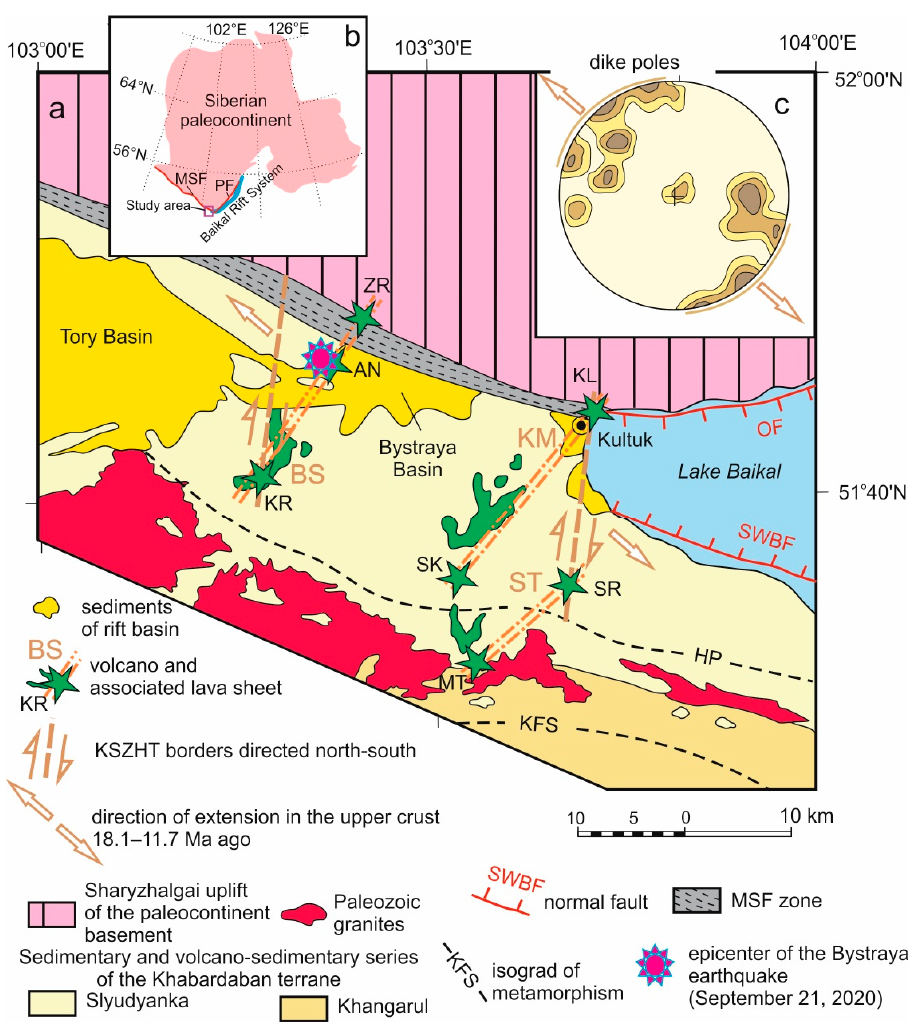
Figure 1. Geological map of the junction area between the lacustrine South Baikal Basin and Tunka Valley ( a ), location of the study area on the southern edge of the Siberian paleocontinent,